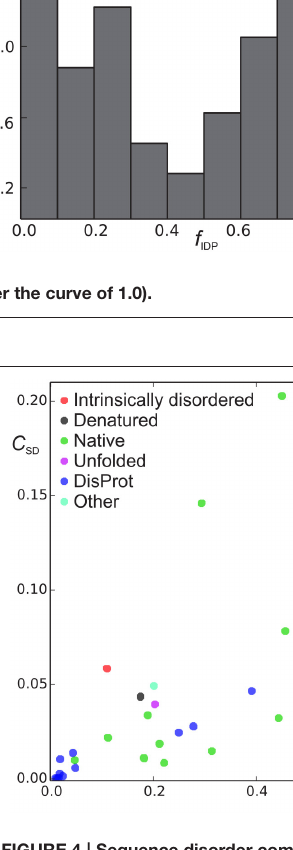
FIGURE 4 | Sequence disorder complexity, C SD (Equation 6), as a function of the fraction of disordered residues, f D . Each protein is shown with a different color according to the “physical_state” tag provided in the BMRB database. The proteins shown in blue were found in the DisProt database search, where proteins shown in blue had “physical_state” = “native” and cyan points refer to as “unknown” or had missing specification of “physical_state” in the BMRB file. The proteins shown with other colors than blue and gray were found in the BMRB database key word